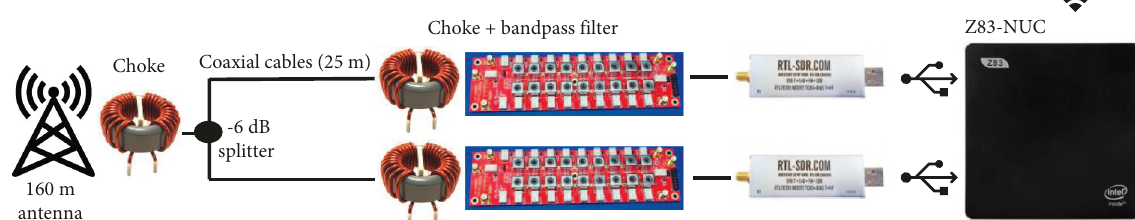
Figure 1: Double identical WSPR receiver setup using two RTL dongles, the ITA LWA II long wire antenna, and a power splitter for calibration